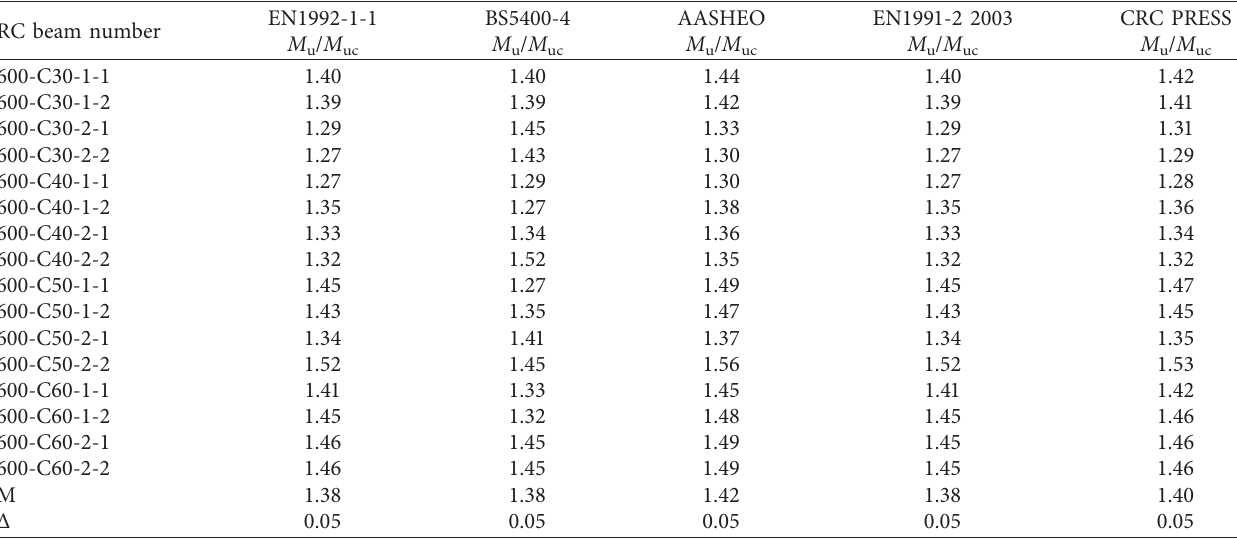
u with M uc calculated by code of 520MPa for the reinforcement design